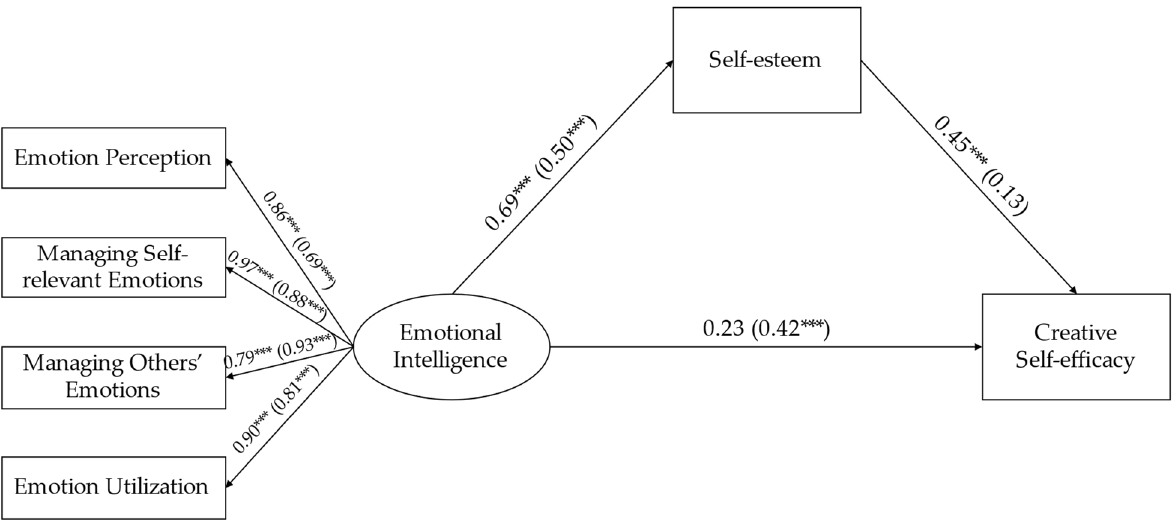
Figure 3. A multigroup model comparison of the mediating effect of self-esteem. *** p < .001; The numbers are standardized regression coefficients, which boys’ coefficients are outside brackets, and girls’ coefficients are inside brackets. The residuals variances and controlled variable (age) in the model are not displayed.